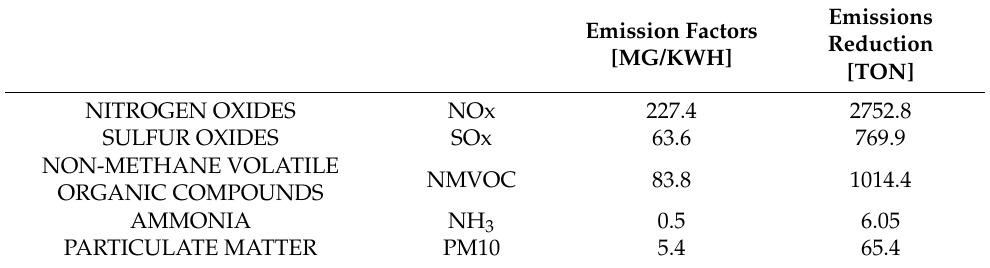
Table 4. Emission factors and total reduced emissions for the main pollutants of Italian power